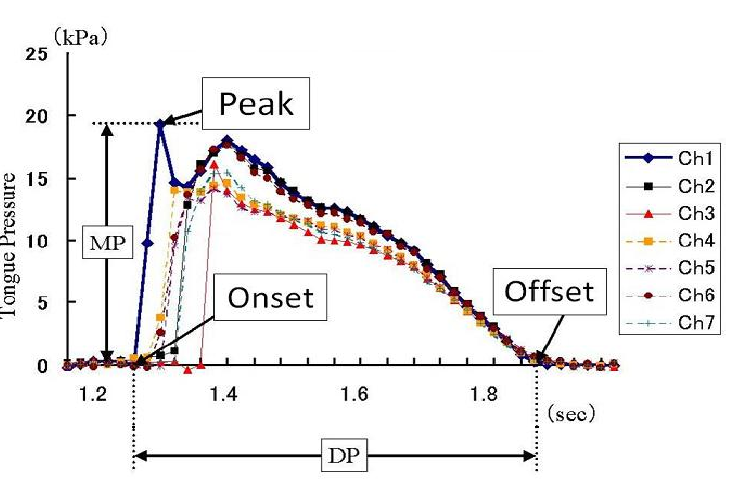
Figure 9. Example of the recording and method of analysis of tongue pressure production (MP, magnitude of tongue pressure; DP, duration of tongue pressure)